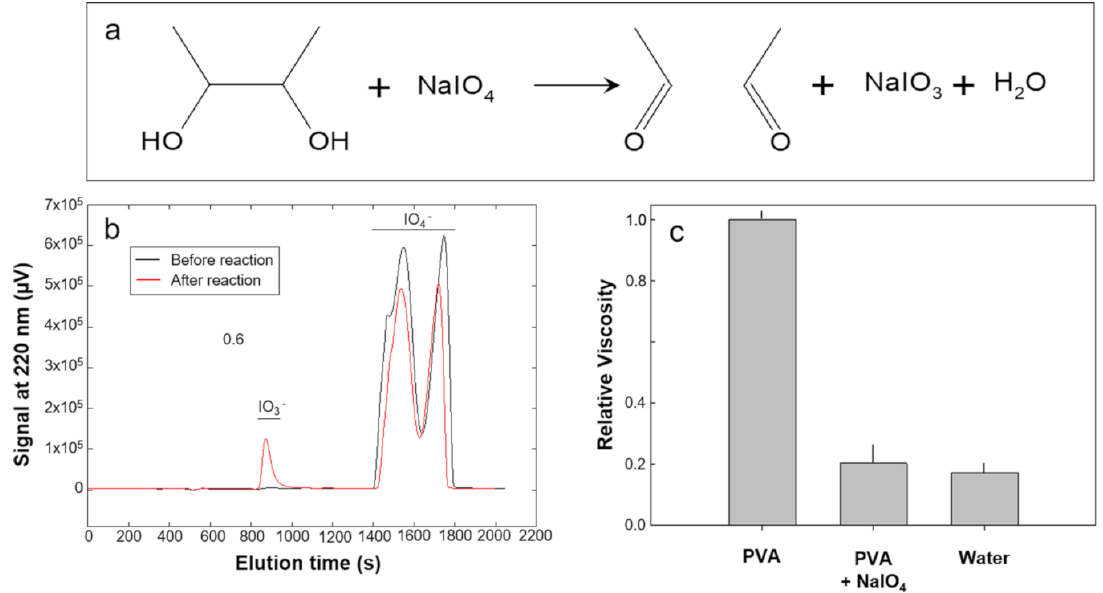
Figure 1. 1,2-diol content and relative viscosity of PVA. ( a ) Reaction between 1,2-diols and NaIO 4 , leading to the cleavage of the single bond connecting the two carbon atoms carrying the hydroxyl groups. ( b ) Separation by ion-pairing HPLC of periodate (IO 4 − ) and iodate (IO 3 − ) ions before and after reaction with polyvinyl alcohol (PVA). Interestingly, the elution profile of IO 4 − ion is complex, probably because the amount of modifier cetyltrimethylammonium chloride is not enough to transform the IO 4 − species in a single type of ionic couple. ( c ) Relative viscosity of a solution containing 2% (w/w) PVA in water after reaction with NaIO 4 .